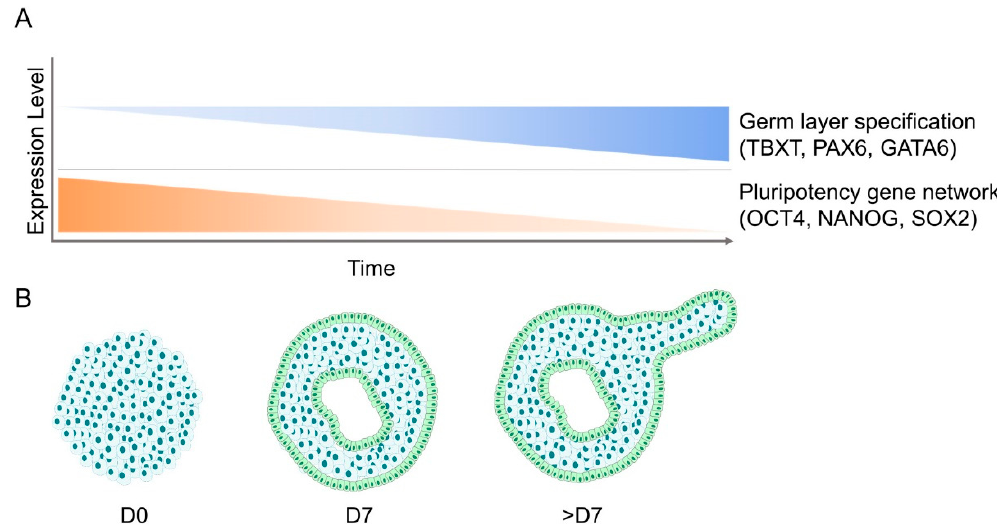
Figure 2. Gene expression and morphological changes during the course of EB development. ( A ) Gene expression patterns of embryoid bodies show simultaneous upregulation of germ layer-specific markers (Brachyury, PAX6, GATA6) and downregulation of pluripotency-related genes (OCT4, NANOG, SOX2) over the course of their differentiation. ( B ) Morphologically, EBs transition from a dense mass of cells into fluid-filled cavitated structures that can later develop additional appendages.